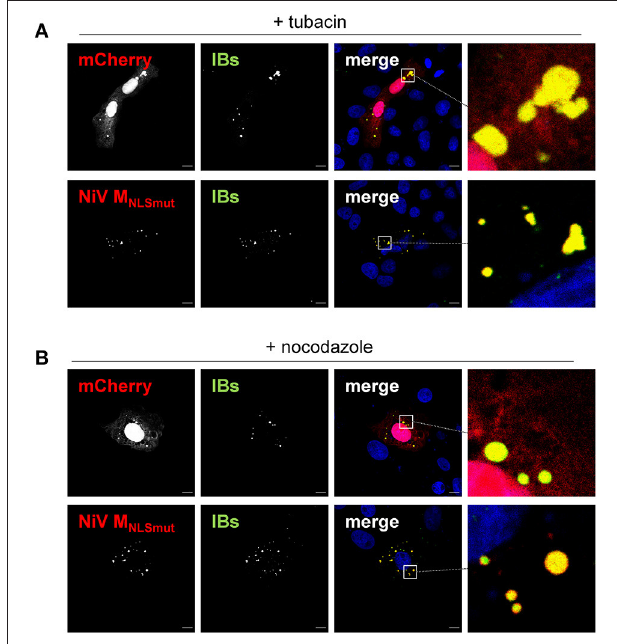
FIGURE 8 | Influence of HDAC6 inhibition and MT disruption on protein recruitment to IBs. Vero76 cells were transfected with plasmids encoding NiV N and NiV PeGFP together with either mCherry or NiV M NLSmut . After 4h, cells were treated with either 10 µ M tubacin (A) or 250nM nocodazole (B) . 24h post transfection, cells were fixed with 4% PFA and permeabilized with Triton X-100. mCherry and eGFP were detected by autofluorescence (green, red). NiV M NLSmut was detected using an M-specific antiserum (red). Nuclei were counterstained with DAPI (blue). Boxed areas are shown at higher magnification on the right. Scale bars, 10 µ